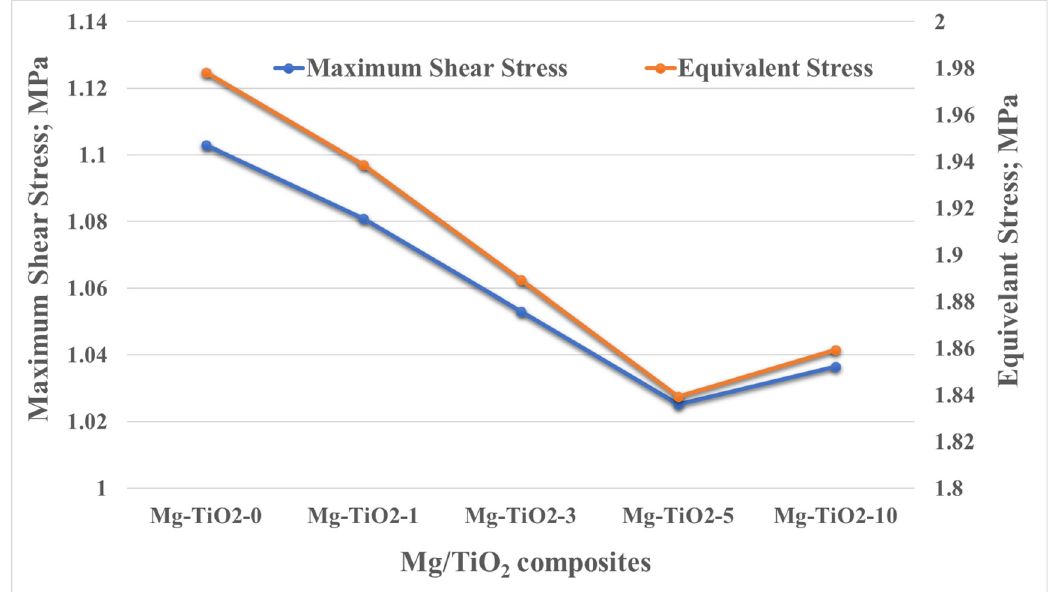
Figure 12. Resultant contact stresses on Mg/TiO 2 composite surfaces.